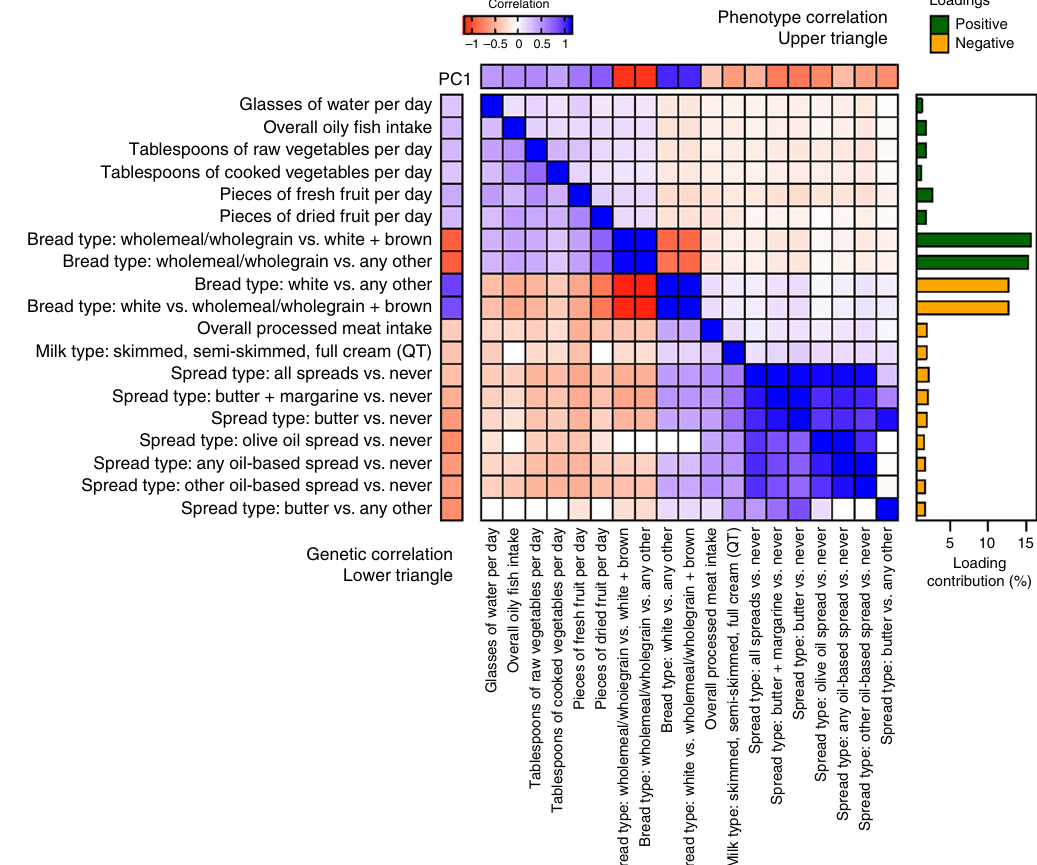
Tablespoons of cooked vegetables per day Pieces of fresh fruit per day